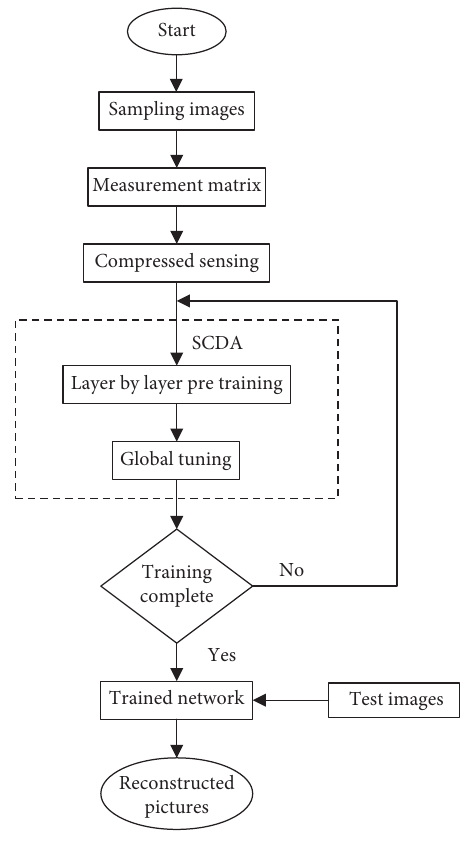
Figure 2: The model diagram of SCDA